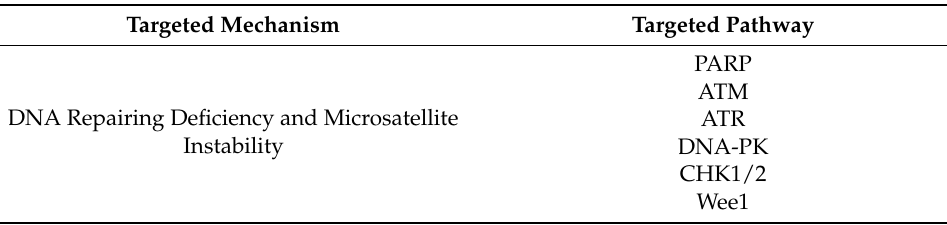
Table 3. Summary of mechanisms of oncological